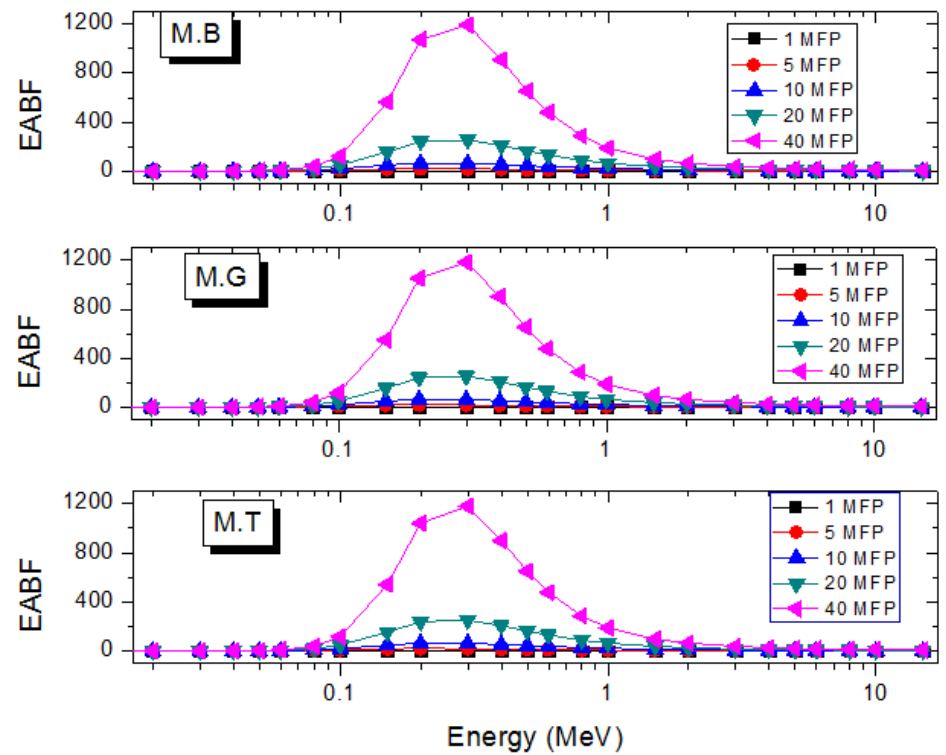
Figure 7. Variation of EABF of the marble samples with energy at selected depths.